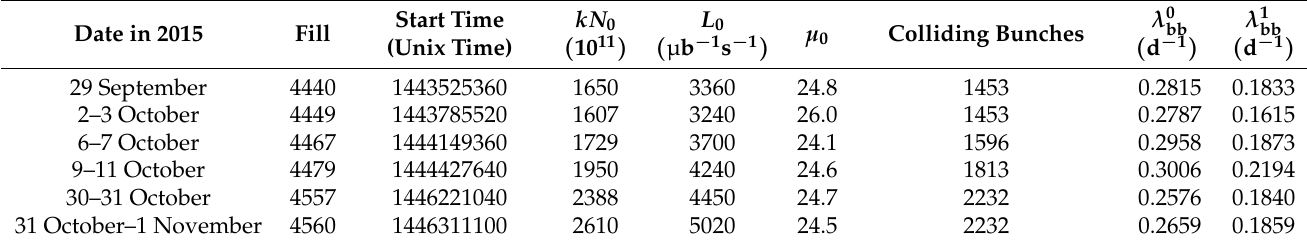
Figure 36. Average number of interactions per bunch crossing as a function of time, seen by TPX02 layer 2 in hit-counting mode. The distribution is approximately described by a function as given in the figure. The parameters are defined in the text. The statistical uncertainties per data point are √ indicated. They depend on the hit statistics scaled by a factor 10. For the first time intervals, the λ bb is calculated analytically from the LHC parameters, and for the subsequent time intervals, λ bb is (cid:112) µ i / µ 1 , where the index corresponds to the time period. Taken from Ref. [14]. scaled with Table 15. Parameters of the LHC proton–proton collisions for the 2015 fills analyzed with TPX02 and TPX12 in the fitting of LHC luminosity reduction curve. L 0 is the luminosity, and µ 0 is the average number of interactions per bunch crossing at the start of the LHC fill. The λ 0 is given for the start of the LHC fill, and λ 1 is given at the start time of the fit for the first bb bb time period. Taken from Ref.